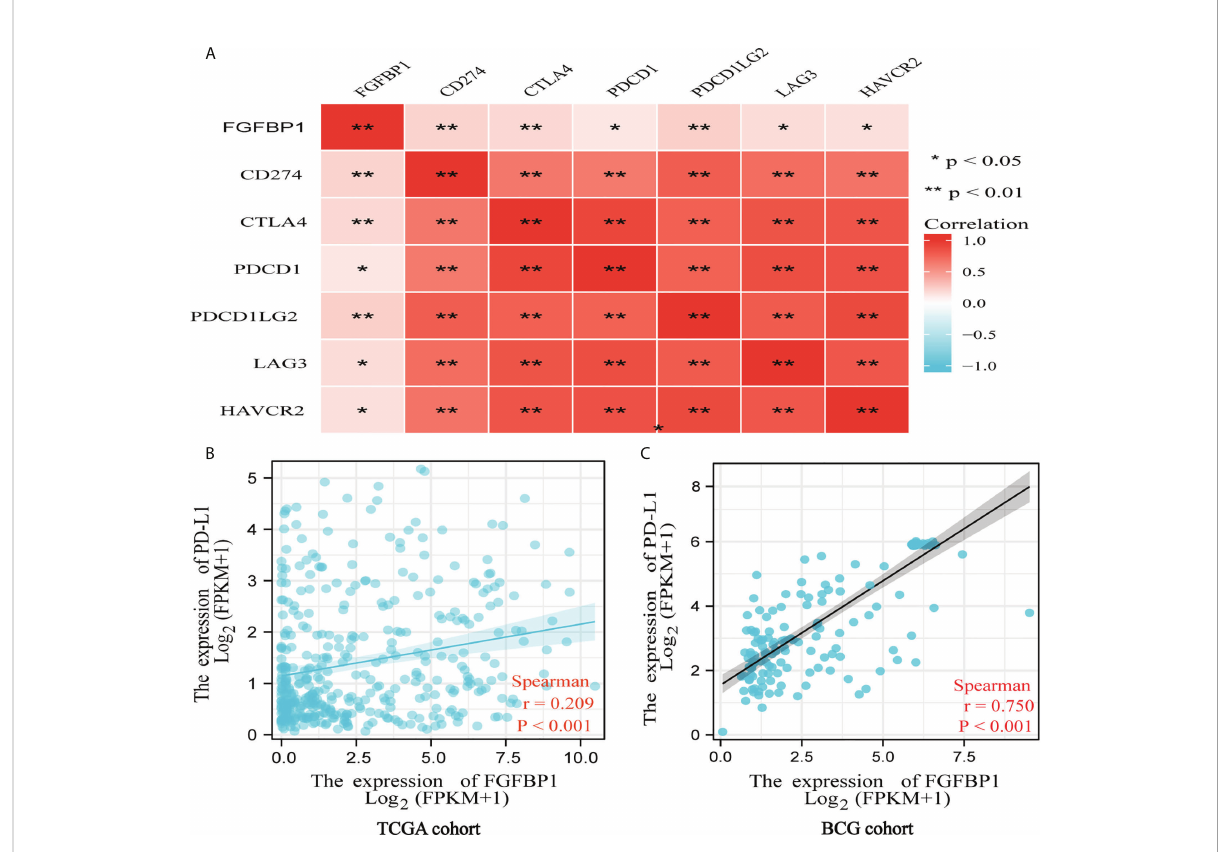
FIGURE 4 FGFBP1 is positively associated with PD-L1 indicated by bioinformatic analysis. (A) FGFBP1 was positively correlated with PD-L1, CTLA4, PDCD1, PDCD1LG2, LAG3, and HAVCR2. (B) FGFBP1 was positively associated with PD-L1 expression in TCGA cohort. (C) FGFBP1 was positively associated with PD-L1 expression in the BCG